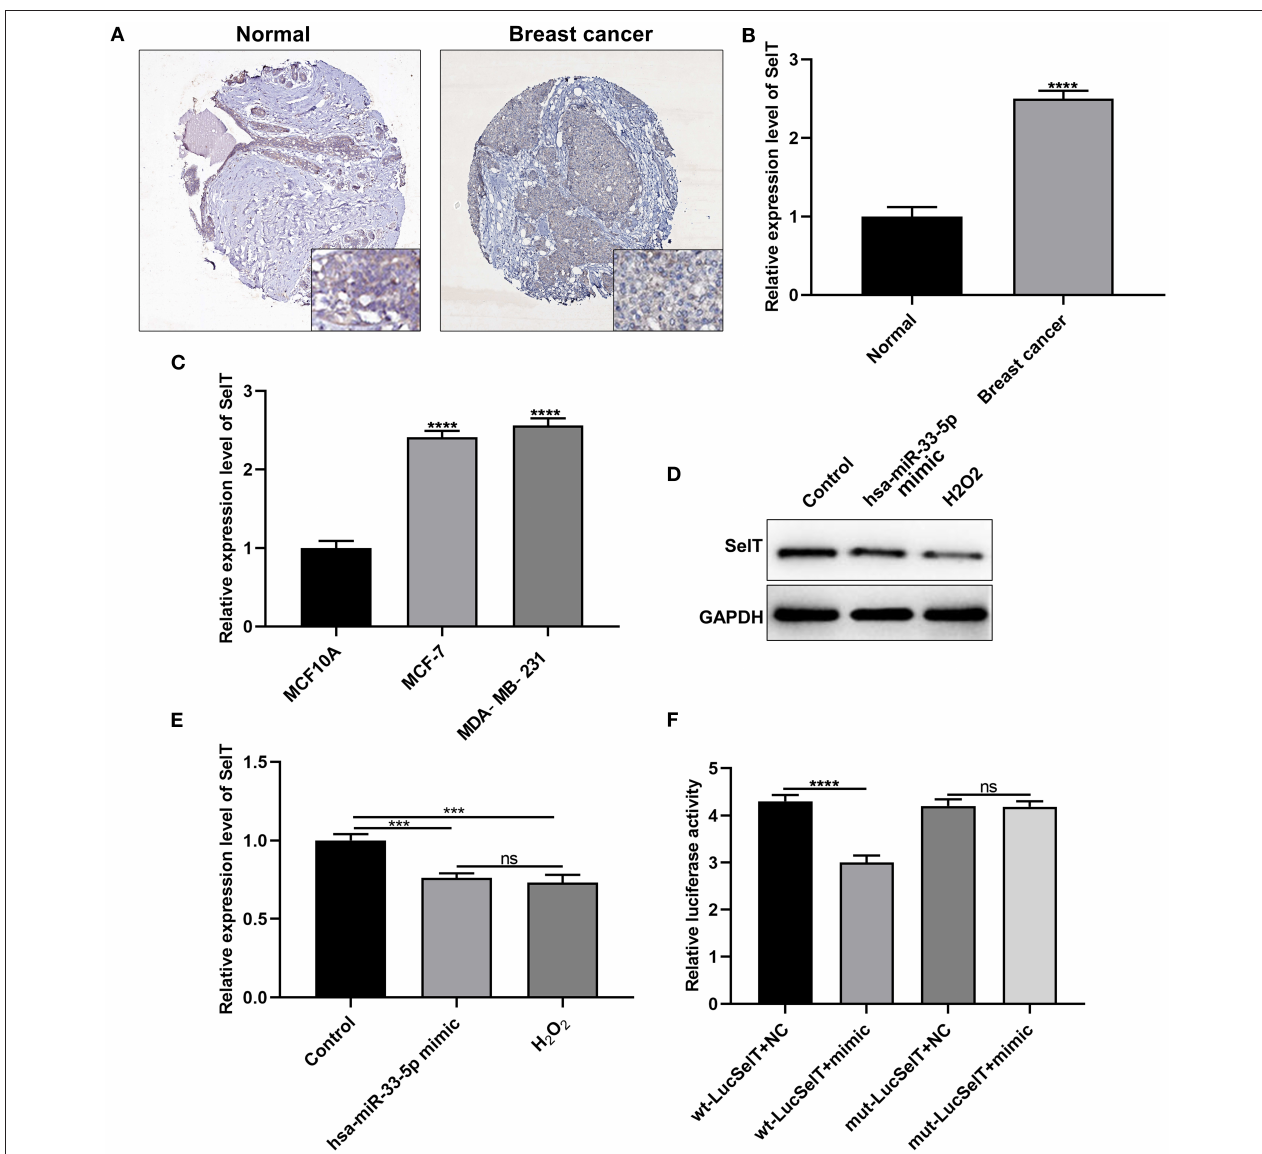
FIGURE 3 | SelT is upregulated in breast carcinoma and is an underlying target of hsa-miR-33-5p. (A) Immunohistochemistry for the expression of SelT in breast cancer and normal tissues. (B,C) RT-qPCR results showing upregulated SelT both in breast cancer tissues (B) and cells (C) . (D,E) Western blot results for the expression of SelT in breast cancer cells transfected with hsa-miR-33-5p mimics or treated with H 2 O 2 . (F) Luciferase reporter assay for hsa-miR-33-5p and SelT. *** p < 0.001; **** p < 0.0001; ns, not significant.